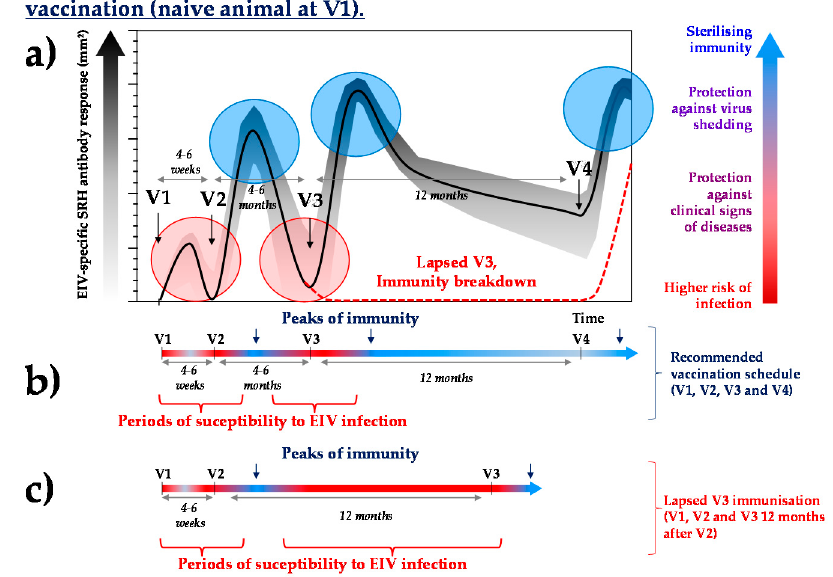
Figure 3. Kinetics schematic of the EIV-specific antibody response ( a ) induced by recommended vaccination schedules ( b ) ([29–37]) and potential impact of lapsed V3 immunisation ( c ). Blue circles represent usual peaks of immunity, red circles show usual periods of susceptibility to EIV infection. SRH = single radial haemolysis.